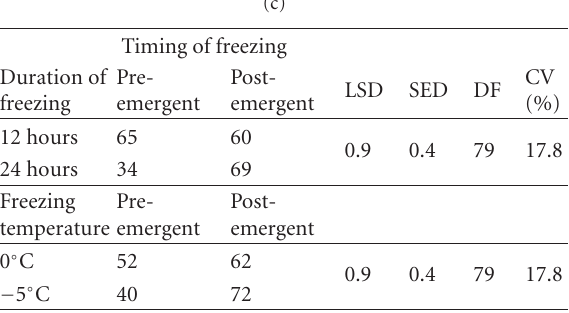
Final emergence of non-frozen seedlings 71%. Data are back transformed, statistical analysis performed on square root transformed data.